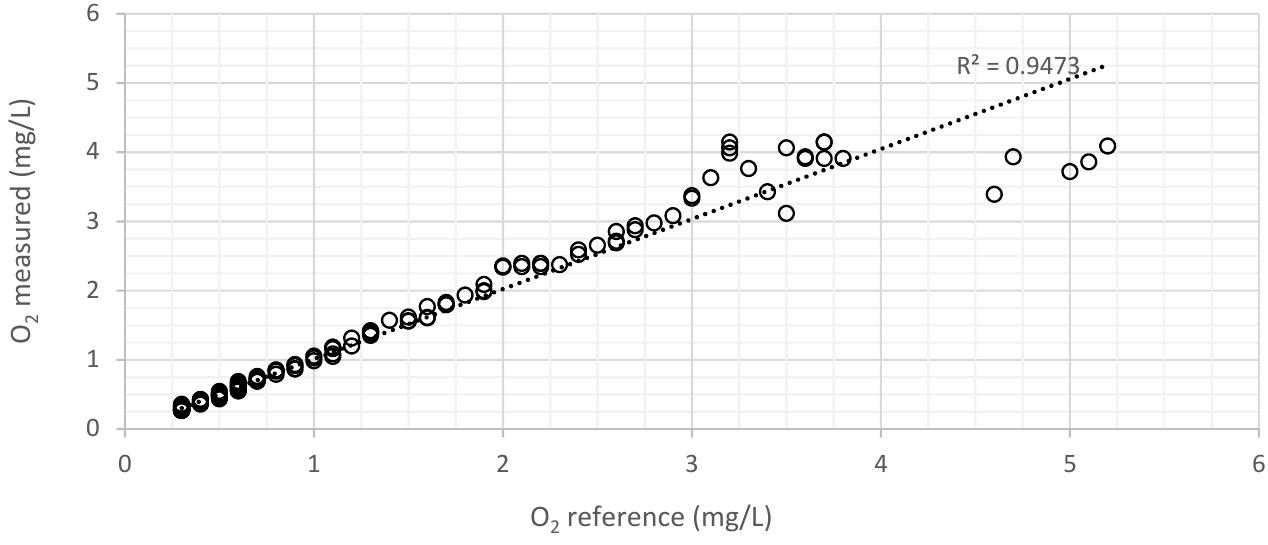
Figure 13. Variation of the DO values measured by the developed sensor as a function of the reference DO values (measured with the commercial sensor) for the membrane with a concentration of 363 ppm with 1.4 mm and manufactured with THF, in a liquid environment, obtained with the Stern–Volmer equation (Equation (1)).